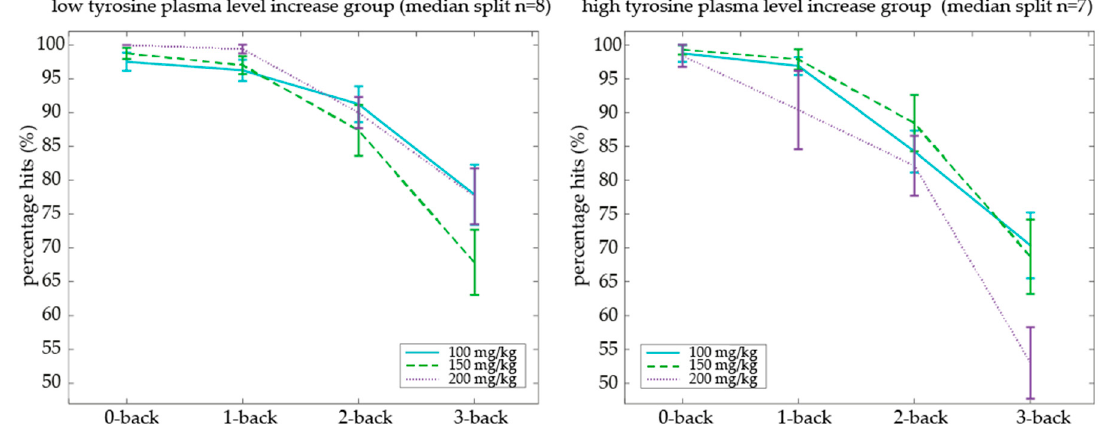
Figure 6. Effect of tyrosine dose and cognitive load on accuracy in older adults who had either a low or high dose-dependent plasma tyrosine increase (based on a median split).